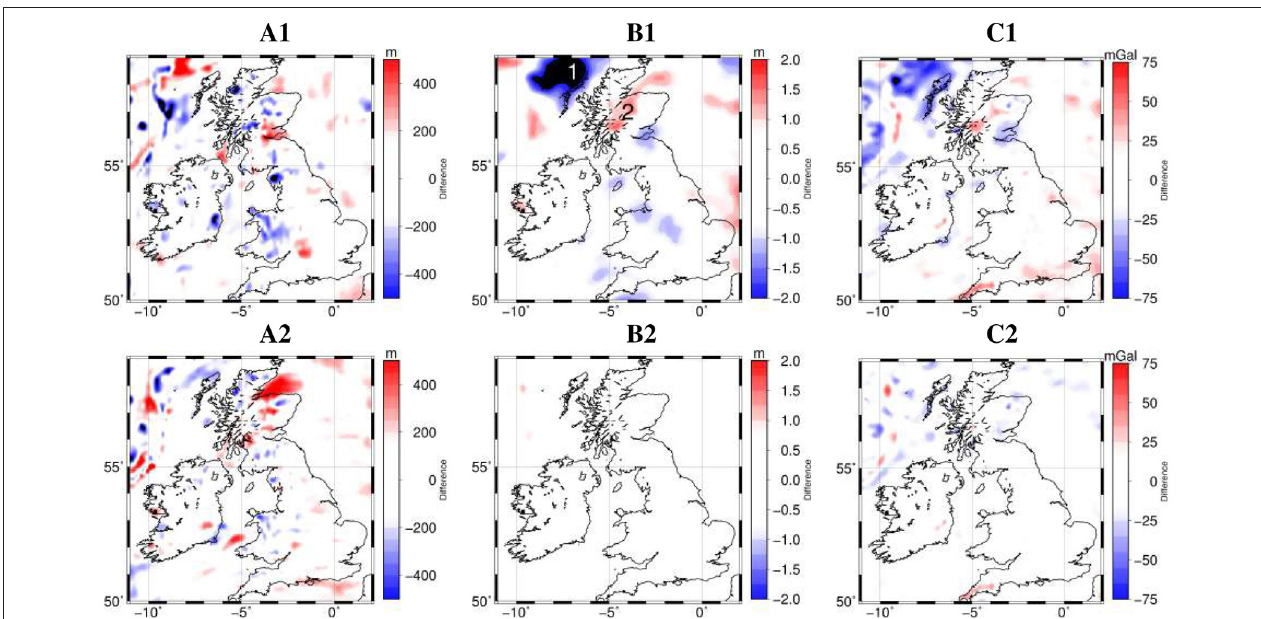
FIGURE 6 | Difference between forward calculated and observed data (from Figure 1 ). (A) Elevation, (B) Geoid anomaly, (C) Bouguer anomaly. First row corresponds to model M1_s (A1–C1) , second row corresponds to model M2_g-elev (A2–C2) .